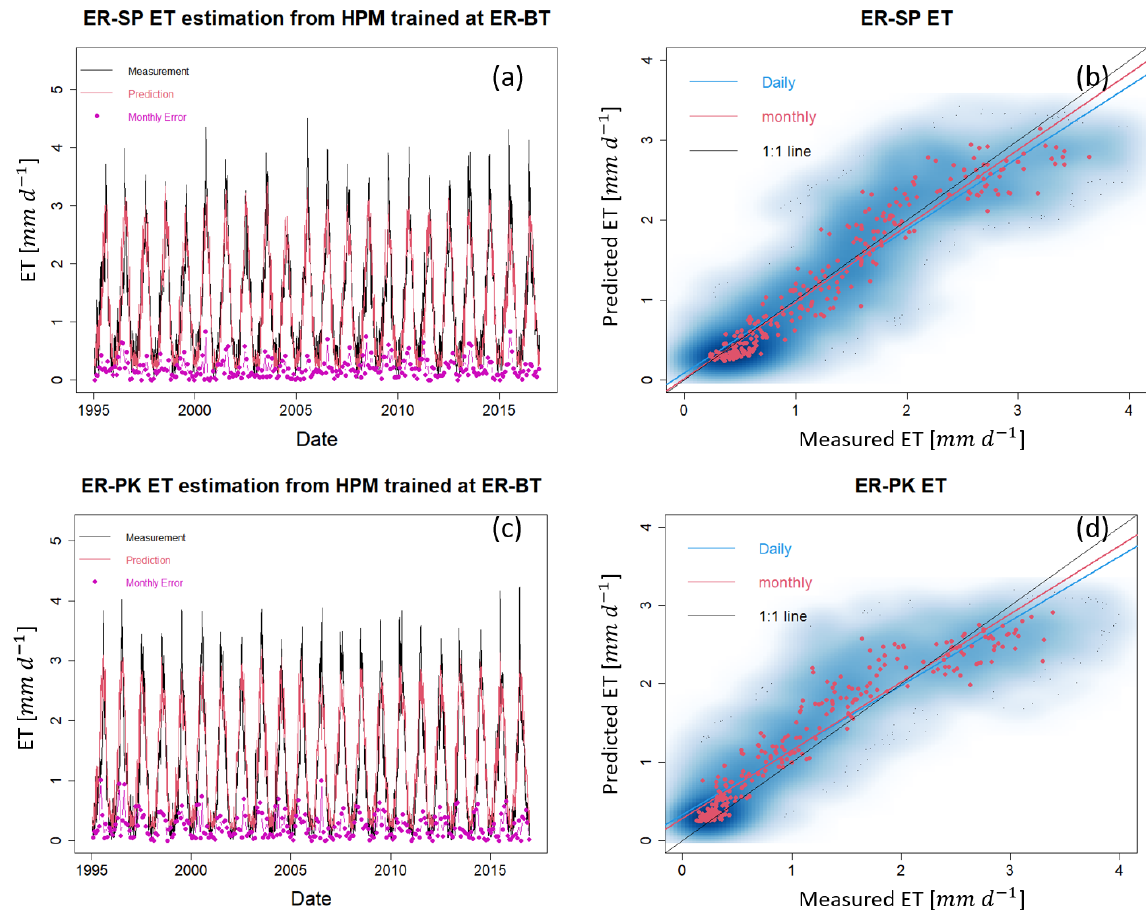
Figure 7. The HPM approach trained with CLM simulation at ER-BT is used to estimate ET at ER-SP and ER-PK. Panels (a) and (c) display the time series of HPM estimation of ET (red lines) and independent CLM estimation at ER-SP and ER-PK. Panels (b) and (d) show the scatter plots of daily (blue) and monthly (red) ET at these sites. Darker blue clouds represent greater density of data points.